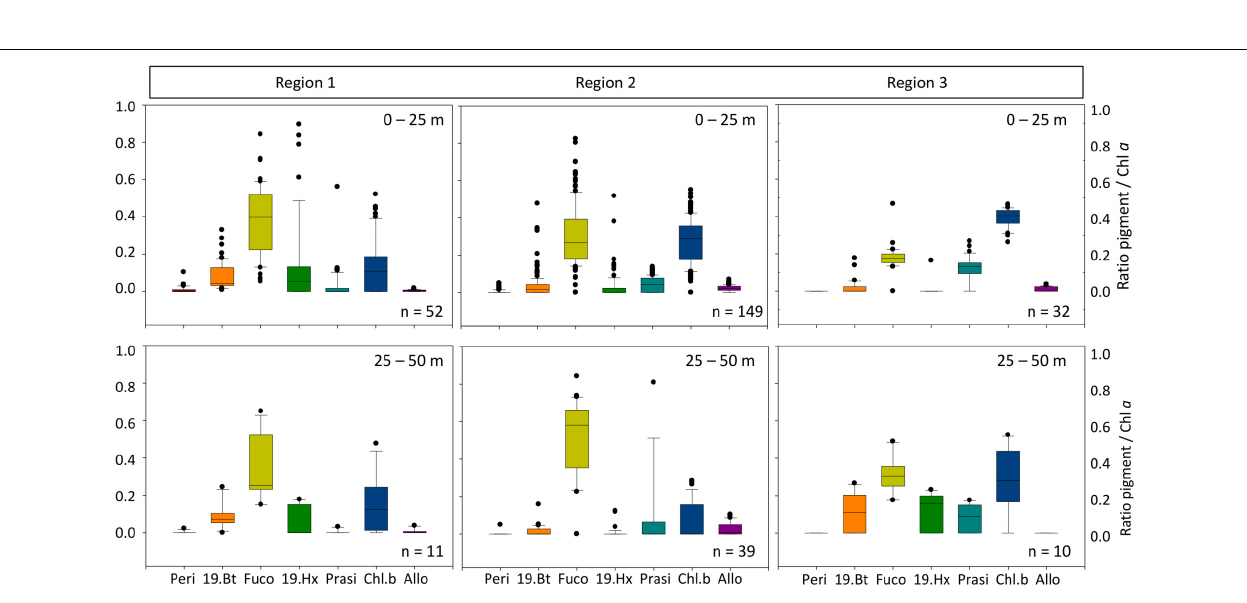
Frontiers in Earth Science |